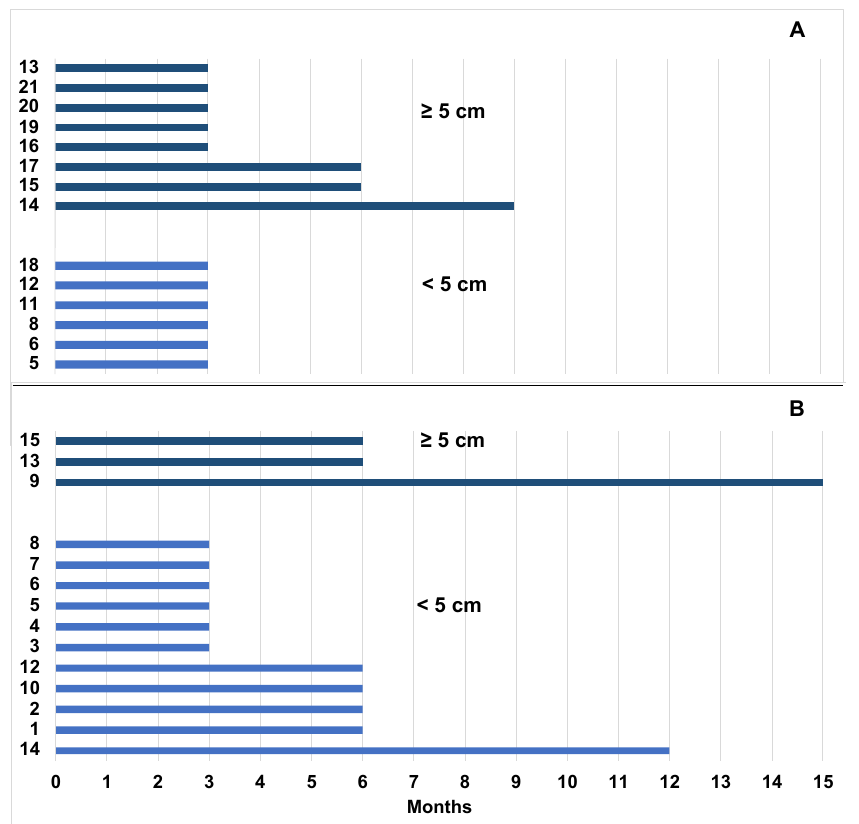
Figure 5. Time to response of LN< 5 cm vs. ≥ 5 cm. ( A ) Patients with AbdLN involvement before the initiation of treatment having LN < 5 cm reached CR at T3; patients having LN ≥ 5 cm, reached CR at T3 (N = 5 pts), at T6 (N = 2 pts), and T9 (N = 1 pts). ( B ) Time to CR of SupLNs < 5 cm (N = 14/15 patients) was T3 (N = 6 pts), T6 (N = 4 pts) and T12 (N = 1 pts). If SupLNs were ≥ 5 cm time to CR was T6 (N = 2 pts), and T15 (N = 1 pts).